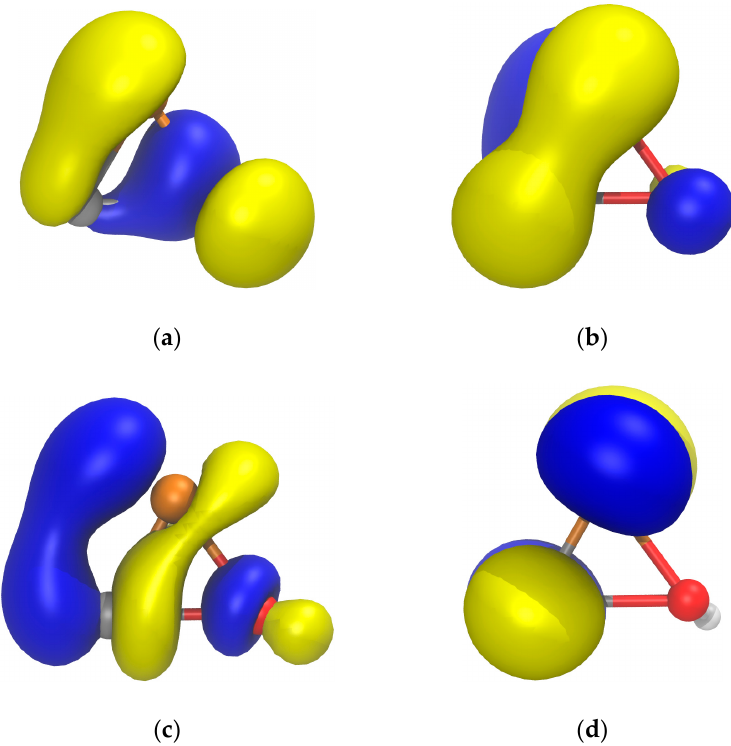
Figure 3. Computed (B3LYP/def2-TZVPP) Kohn–Sham isosurfaces (0.06 au) for ( a ) HOMO-3, ( b ) HOMO, ( c ) LUMO, and ( d ) LUMO+1 of 4a .